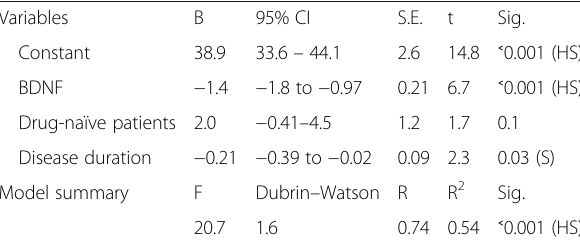
Table 5 Multiple linear regression analysis of HDRS with BDNF and related clinical